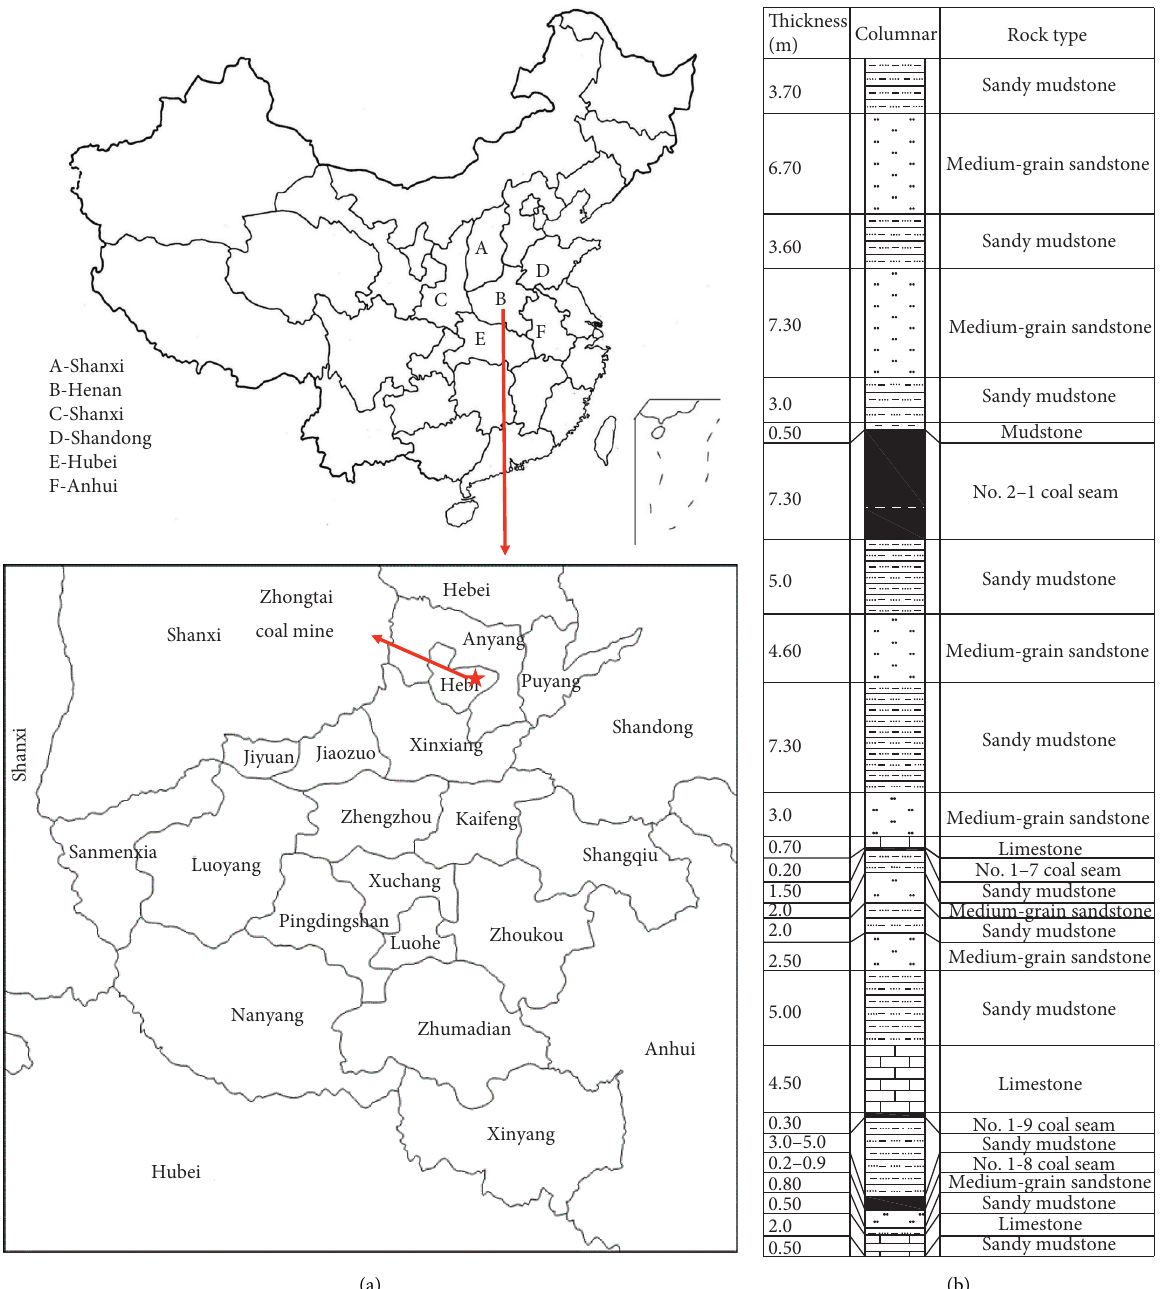
Figure 2: Location map and geological synthesis columnar of the case study mine. (a) Location map of the case study mine; (b) geological synthesis columnar of the case study